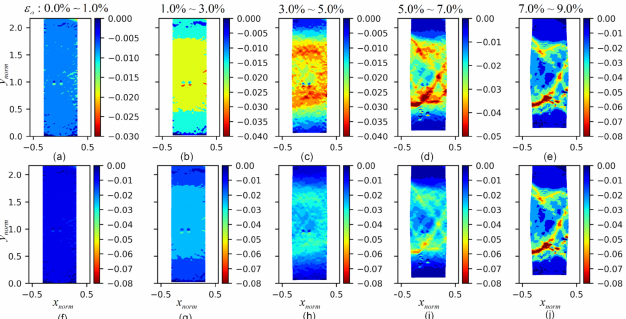
Figure 9. The evolution of the mean fields of gradient along the ˆ y axis F 33 : ( a – e ) the mean fields of F 33 at axial strains of 0.0–1.0%, 1.0–3.0%, 3.0–5.0%, 5.0–7.0%, and 7.0–9.0%, respectively, with varying range colormaps; ( f – j ) the mean fields of F 33 at axial strains of 0.0–1.0%, 1.0–3.0%, 3.0–5.0%, 5.0–7.0%, and 7.0–9.0%, respectively, with consistent range colormaps.